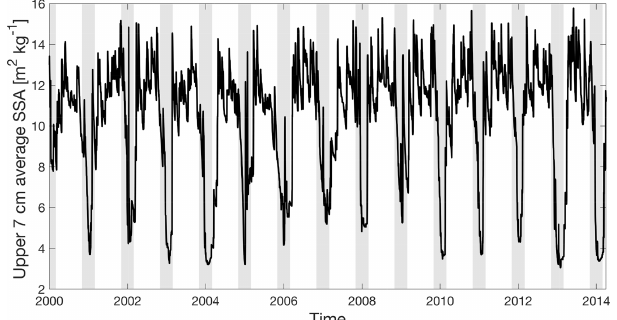
Figure 8. Seasonal cycle of modelled average grain size in the upper 7cm for the period 2000–2014. The grain size is expressed in terms of specific surface area (SSA = 3 ) rather than grain size itself Figure 9. Measured vs. modelled daily average incoming shortwave ρ i r e to allow for a comparison with Fig. 6 of Libois et al. (2015). The radiation (SW ↓ ). The modelled SW ↓ is obtained by dividing the vertical grey patches indicate November–February of each season. hourly measured SW ↑ by the hourly modelled